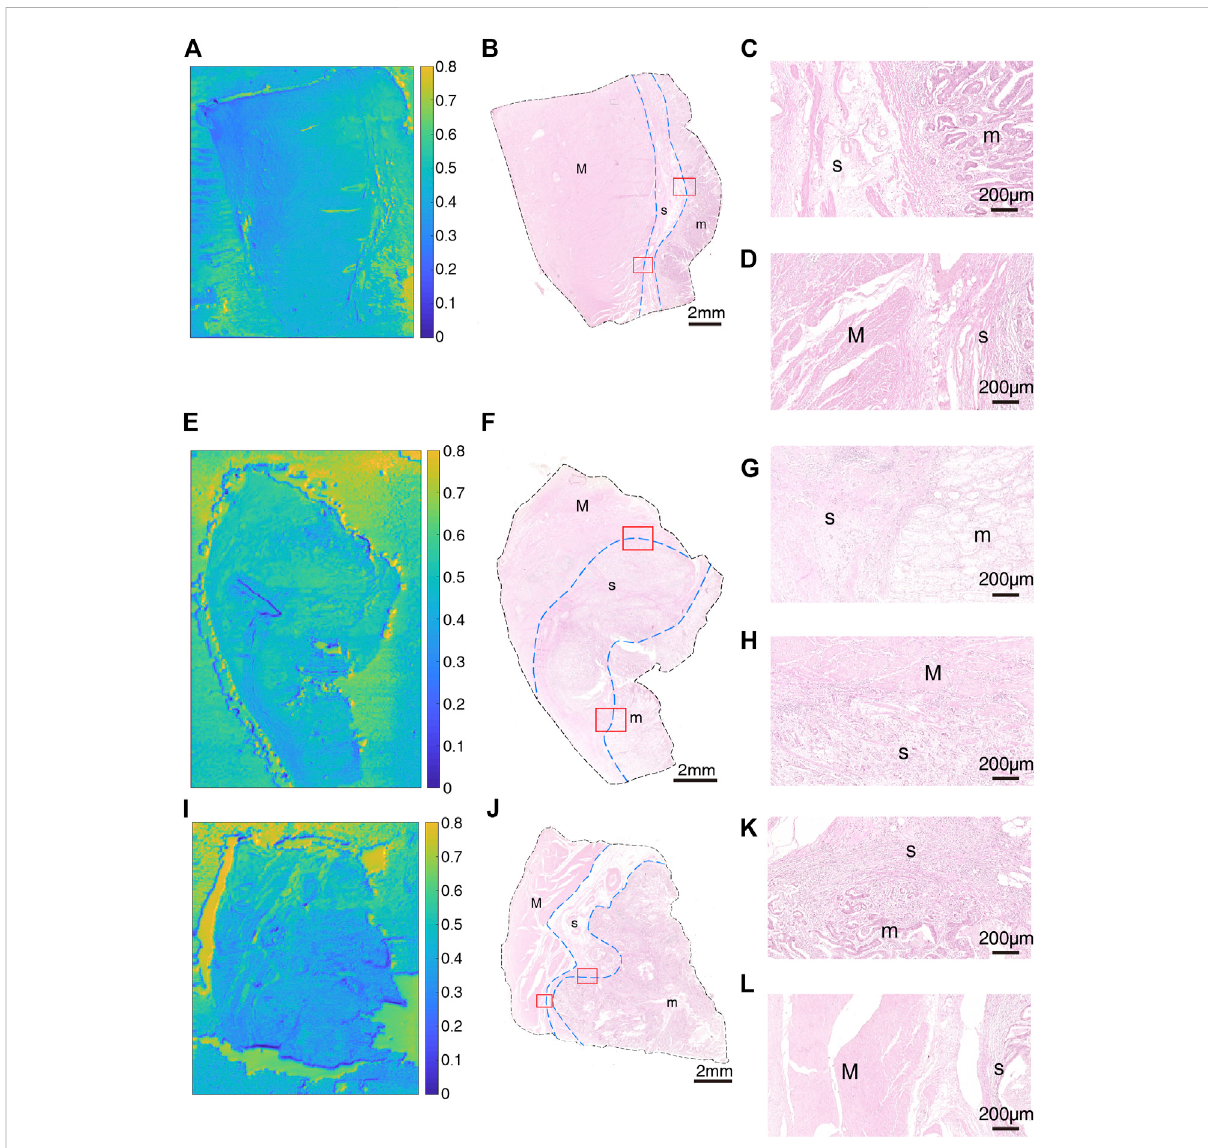
FIGURE 4 Images of GC sample: (A) THz image, (B) H&E-stained slice, and (C,D) H&E-stained images corresponding to the region indicated by the red squarein (B) ofT1; (E) THzimage, (F) H&E-stainedslice,and (G,H) H&E-stained images correspondingto theregionindicatedbytheredsquarein (F) ofT2; (I) THzimage, (J) H&E-stainedslice,and (K,L) H&E-stainedimagescorrespondingtotheregionindicatedbytheredsquarein (J) ofT3.InH&E- stained images, “ m ” indicates “ mucosa ” , “ s ” indicates “ submucosa ” and “ M ” indicates “ muscular layer ” . In images (B,F,J) , the boundaries of mucosa, submucosa, and muscular layer are outlined with dashed blue lines. (C,G,K) are boundaries between mucosa and submucosa. (D,H,L) are boundaries between submucosa and muscular